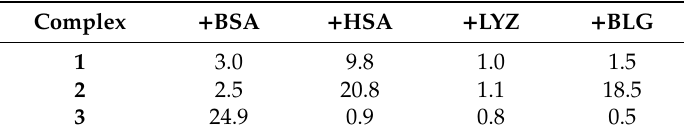
Table 2. Intensities of induced circular dichroism signals ( ∆ ICD; mdeg) for the iron(II) clathrochelates 1 – 3 induced in the presence of globular proteins bovine (BSA) and human (HSA) serum albumin, lysozyme (LYZ) and beta-lactoglobulin (BLG) (c protein = 4 × 10 –5 M, c clt = 2 × 10 –5 M) in 0.05 M Tris–HCl bu ff er with pH